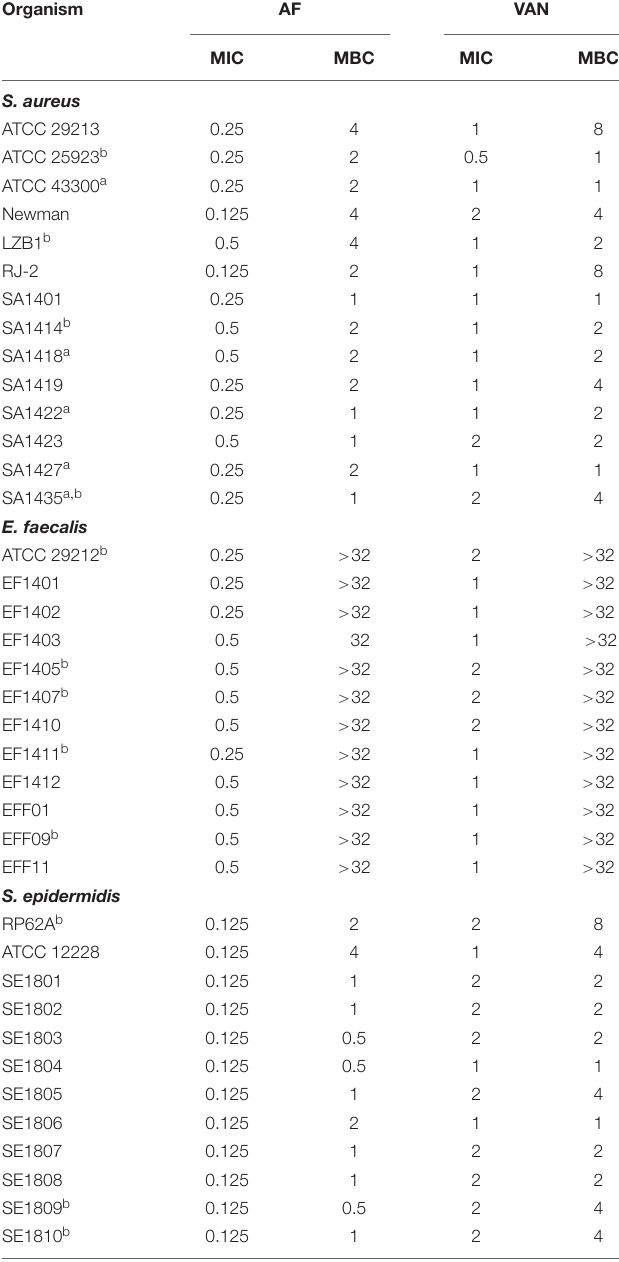
TABLE 1 | Antimicrobial susceptibility testing of AF and VAN toward bacterial strains (mg/L).